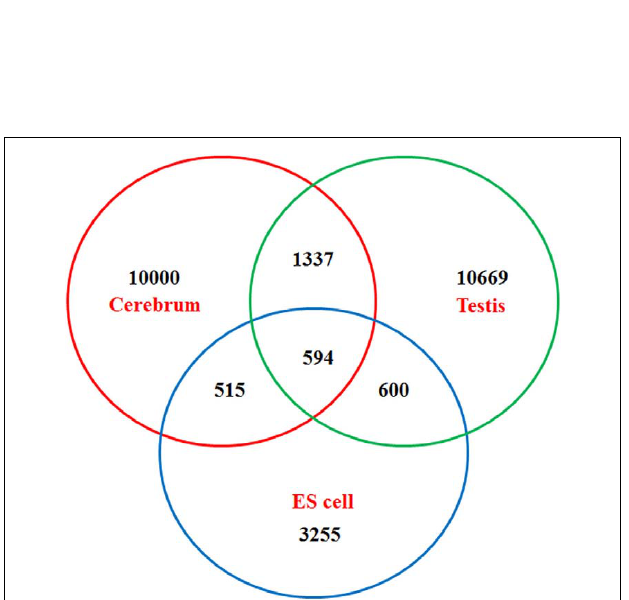
FIGUREA4 |Venn diagram of newly identified non-codingTUs among mouse the cerebrum, testis, and ES cells.